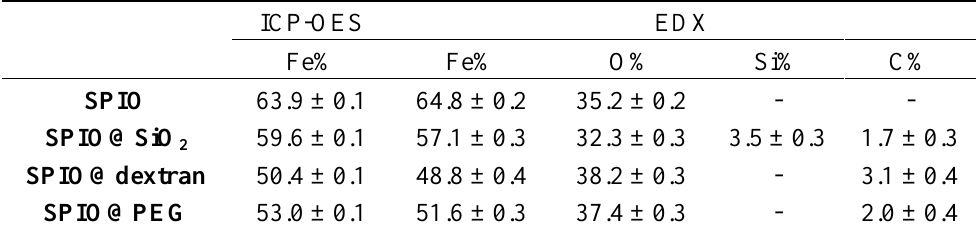
Table 1. Inductively coupled plasma-optical emission spectroscopy (ICP-OES) and energy-dispersive X-ray (EDX)